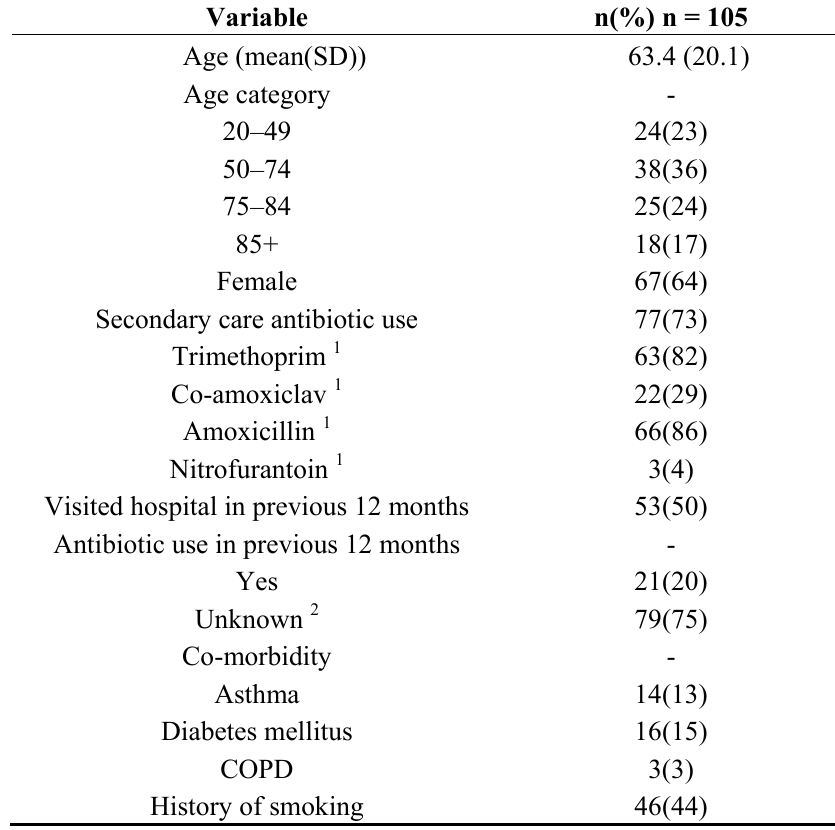
Table 1. Characteristics of patient participating in study.